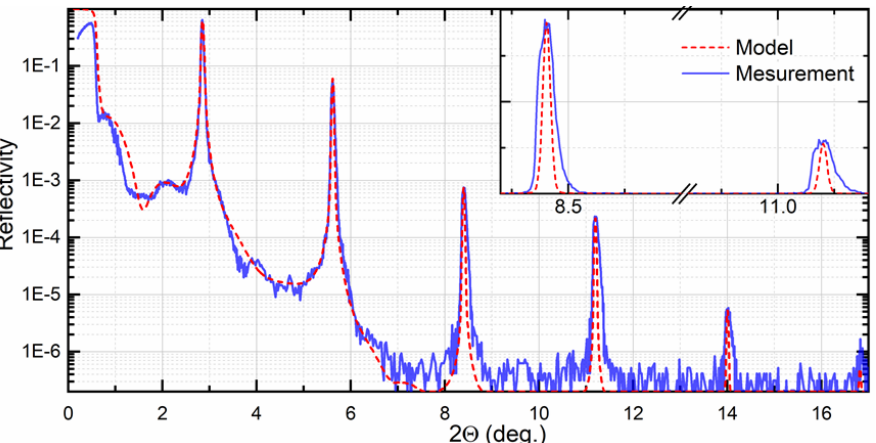
Figure 6. Comparison of measured and calculated low-angle reflectivity curves for Mo/B PMMs having 250 pairs. The inset shows the broadening of the diffraction peak. Reproduced from [44] with permission from Elsevier.